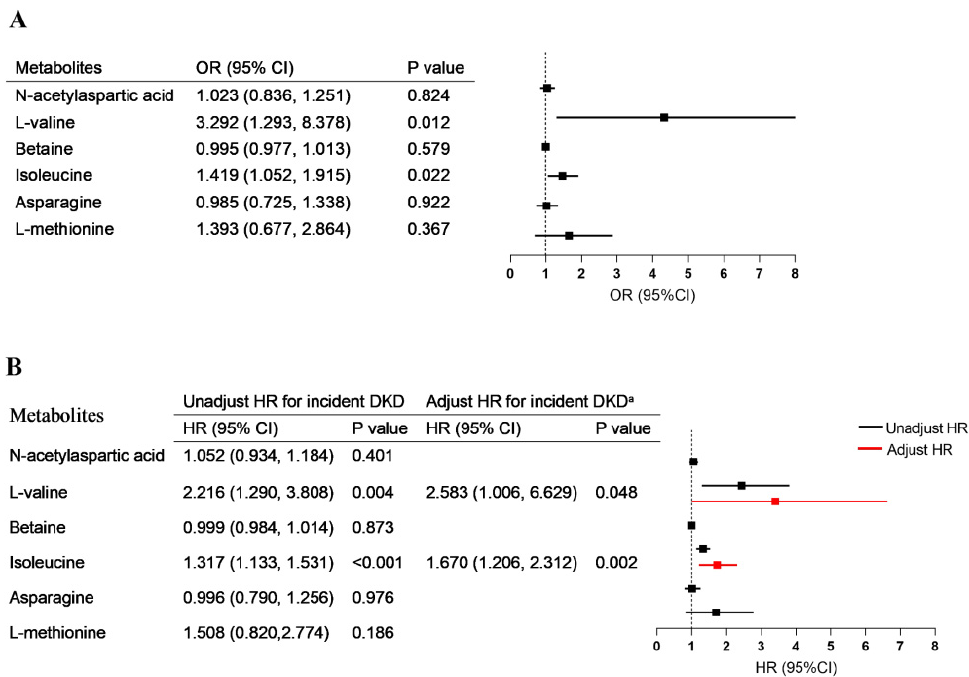
Figure 4. Association of metabolites with diabetes progression. ( A ) The associations of metabolic alterations (per one-point increment) with rapid eGFR decline. ( B ) The association between metabolic alterations (per one-point increment) and risk of new-onset diabetic kidney disease. Adjusted a , without stratification, for age, sex, blood pressure, duration of diabetes, baseline eGFR, and albuminuria. was observed between new-onset DKD and L-valine, isoleucine, and asparagine